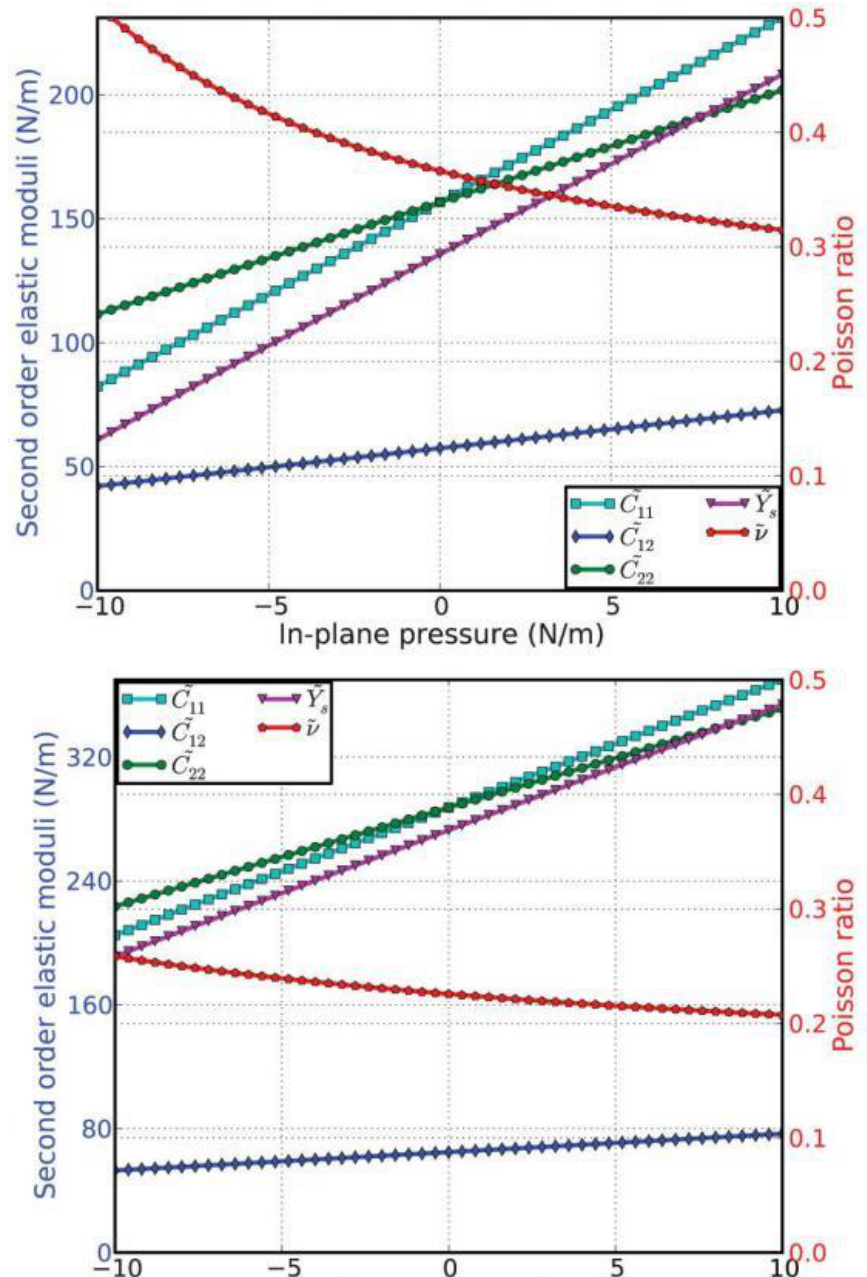
Figure 12. Second-order elastic moduli and Poisson’s ratio as a function of pressure for g-AlN ( top ), compared with g-BN ( bottom ).